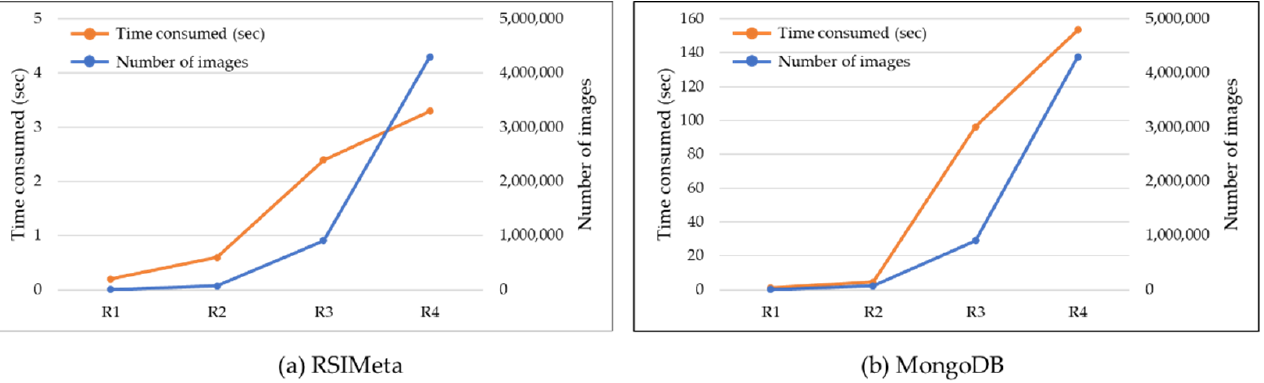
Figure 25. Comparison of geospatial time consumed based on R1, R2, R3 and R4.